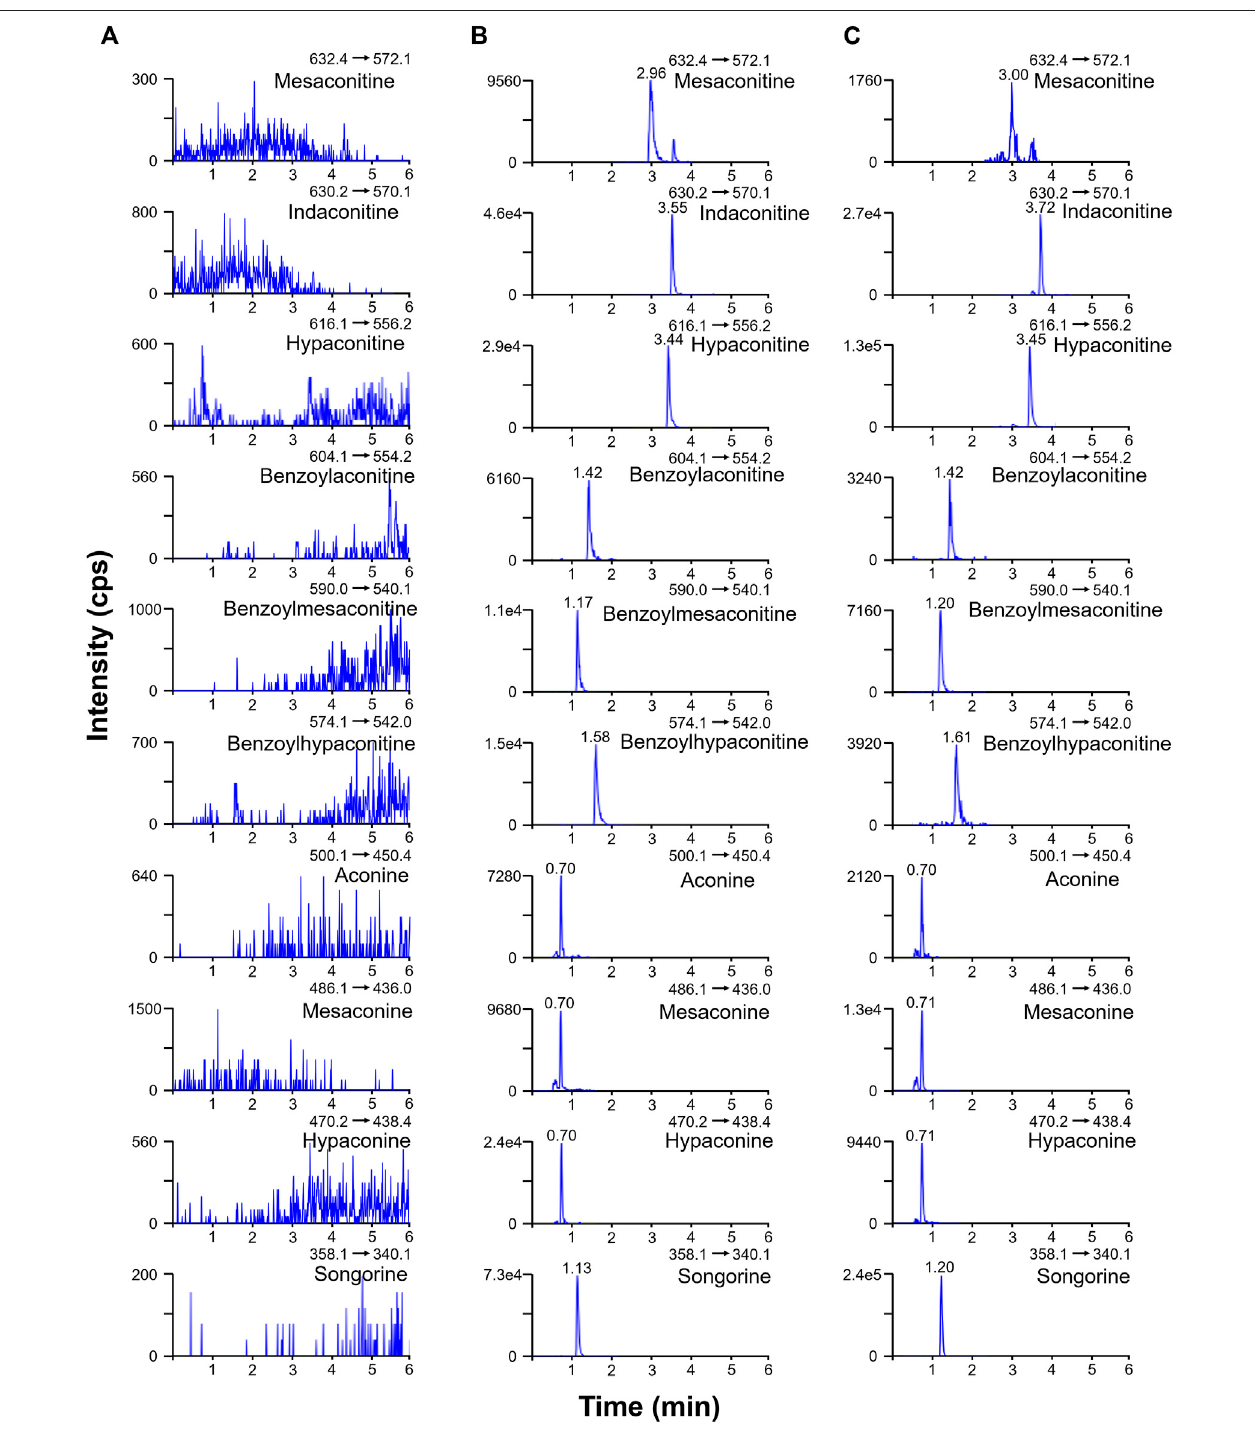
FIGURE 2 | Multiple reaction monitoring chromatograms of blank plasma (A) , spiked standard solution in blank plasma (B) , and the rat plasma sample at 45 min after oral administration of Fuzi (C) .